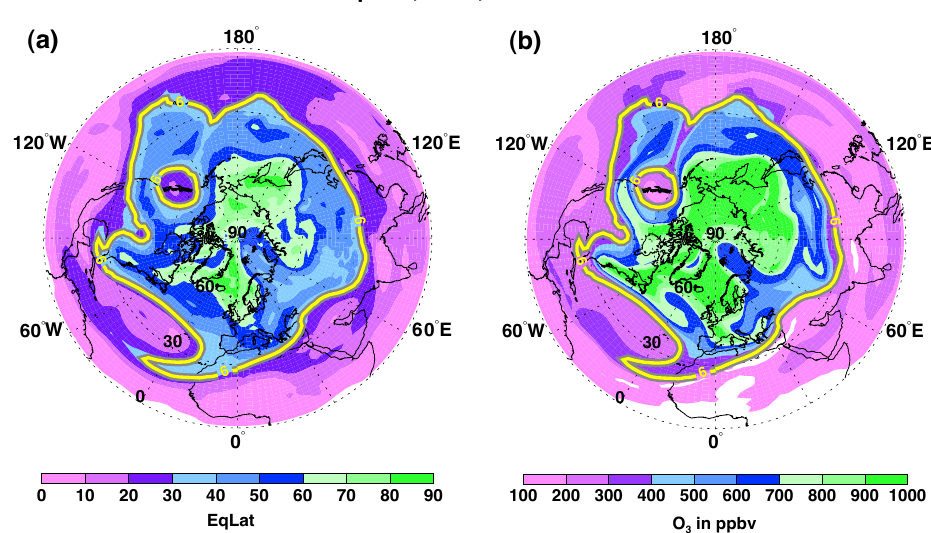
Fig. 10. Maps of (a) EqLat and (b) ozone from the SD-WACCM run for 16 April 2008 at the 380K potential temperature surface. The 6pvu PV contours are shown by the yellow lines. The dynamical tropopause is defined as the pole-enclosing 6pvu